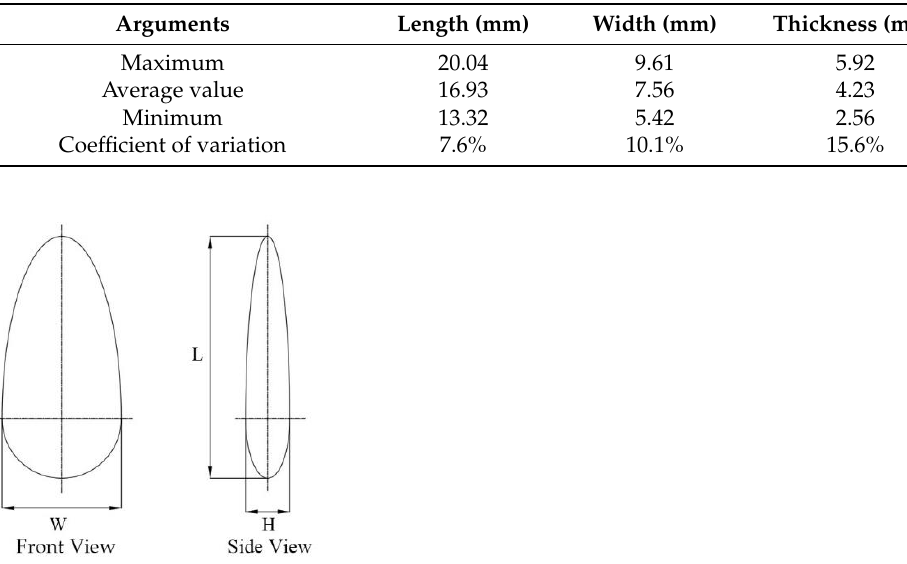
Figure 2. Diagram of the working area: I. Seed-filling area; Ⅱ . Seed-suctioning area; Ⅲ . Seed-adjust-